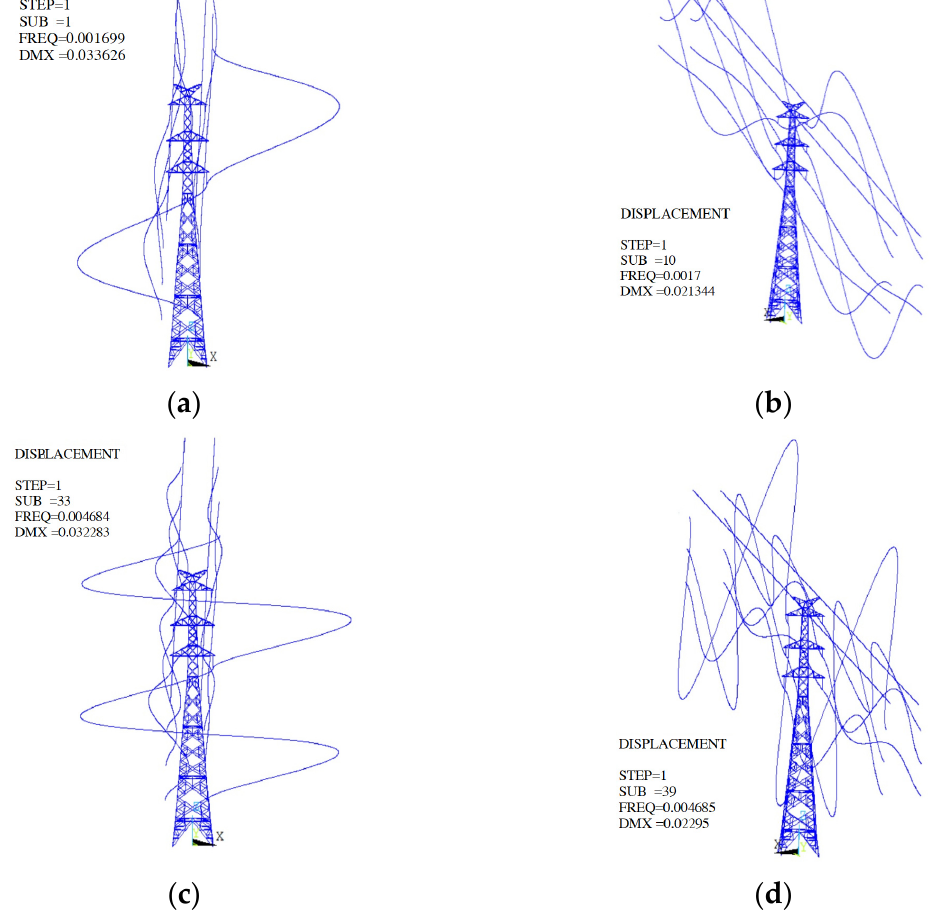
Figure 9. The vibrations of the tower-line coupled model: ( a ) 1st mode; ( b ) 10th mode; ( c ) 33rd mode; ( d ) 39th